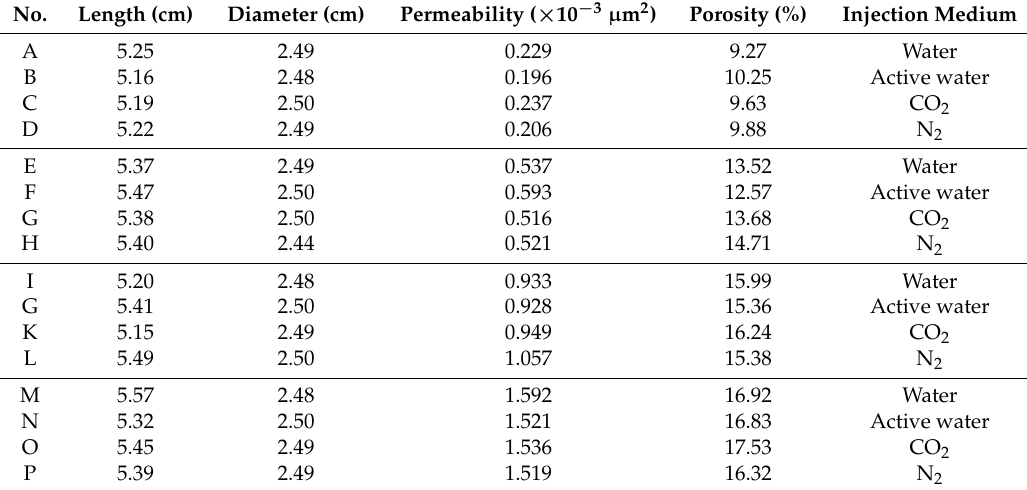
Table 1. Characteristics of the experimental cores.